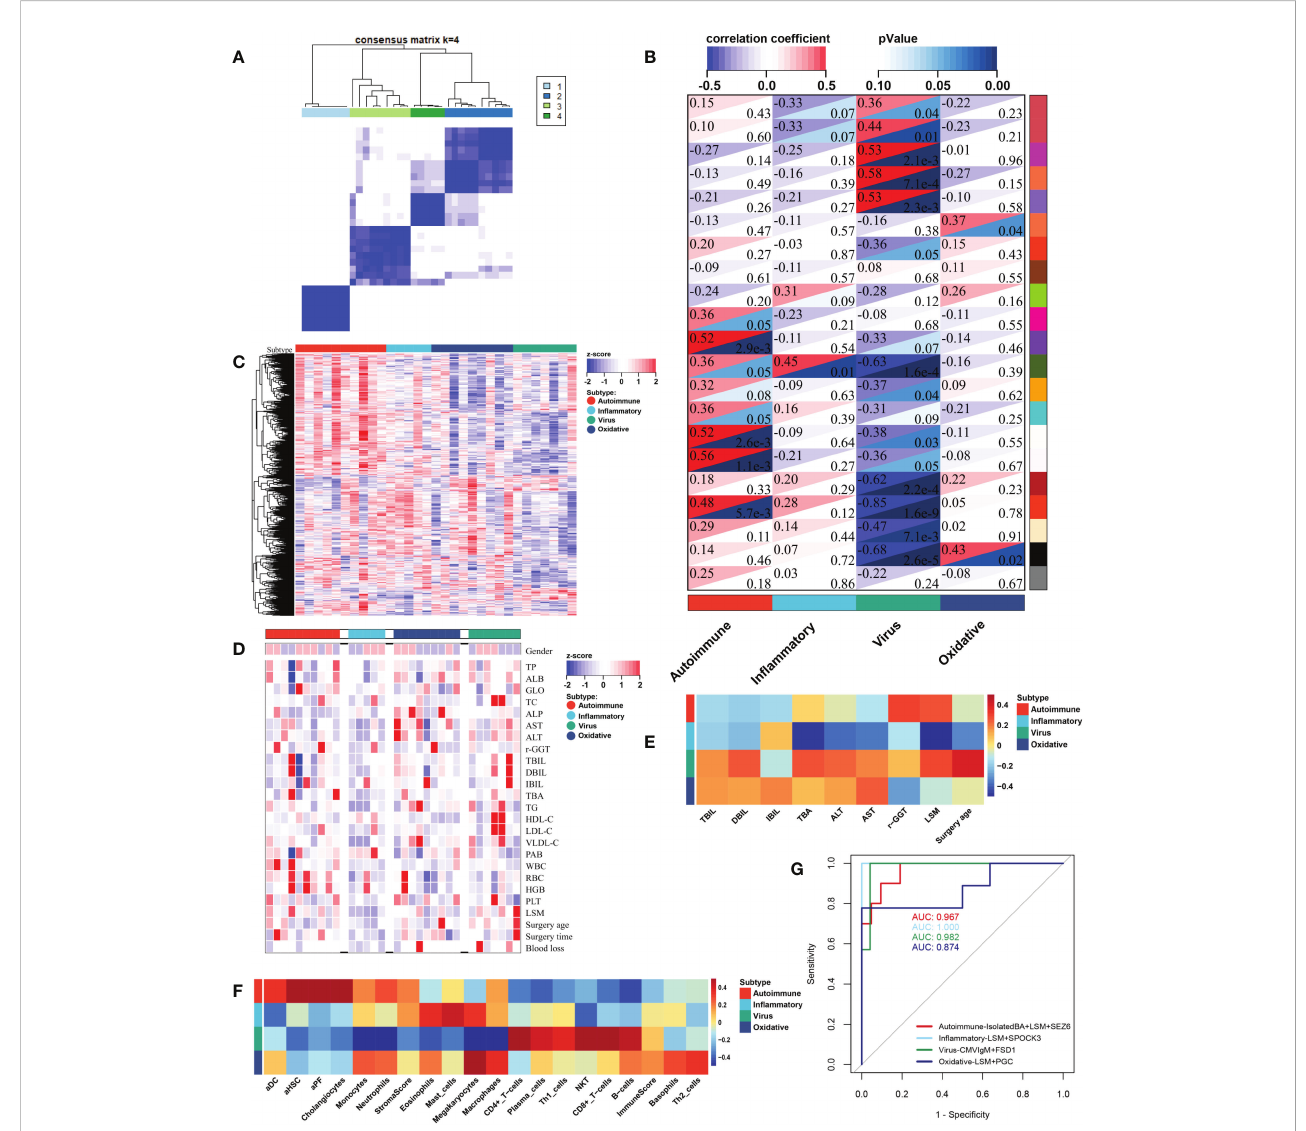
FIGURE 8 Biological function, fi brosis, immune and clinicopathological information of individual molecular subtypes in our central dataset. By applying SNF-CC, 31 BA patients undergoing HPE in our center were clustered into four distinct subtypes (A) . Each subtype was involved with different gene modules of WGCNA (B) . GSVA classi fi ed the patients into four subtypes (C) . Heatmap revealed the clinicopathological features between four molecular subtypes (D, E) . The correlation heatmap showed the fi brosis and immune enrichment scores in each subtype (F) . The ROC results showed integrated classi fi er for distinguishing the four molecular subtypes (G) . aDC, activated dendritic cell; aHSC, activated hepatic stellate cell; aPF, activated portal fi broblast; ALB, albumin; ALP, alkaline phosphatase; ALT, alanine transaminase; AST, aspartate transaminase; DBIL, direct bilirubin; GLO, globulin; HDL-C, high-density lipoprotein cholesterol; HGB, haemoglobin; IBIL, indirect bilirubin; LDL-C, low-density lipoprotein cholesterol; LSM, liver stiffness measurement; NKT, natural killer T cell; PAB, prealbumin; PLT, platelet; RBC, red blood cell; r-GGT, gamma glutamyl transpeptidase; TBA, total biliary acid; TBIL, total bilirubin; TC, total cholesterol; TG, triglyceride; TP, total protein; VLDL-C, very low-density-lipoprotein cholesterol; WBC, white blood cell; SNF-CC, Similarity Network Fusion and Consensus clustering; GSVA, Gene set variation analysis; WGCNA, Weighted Gene Co-expression Network Analysis; HPE,